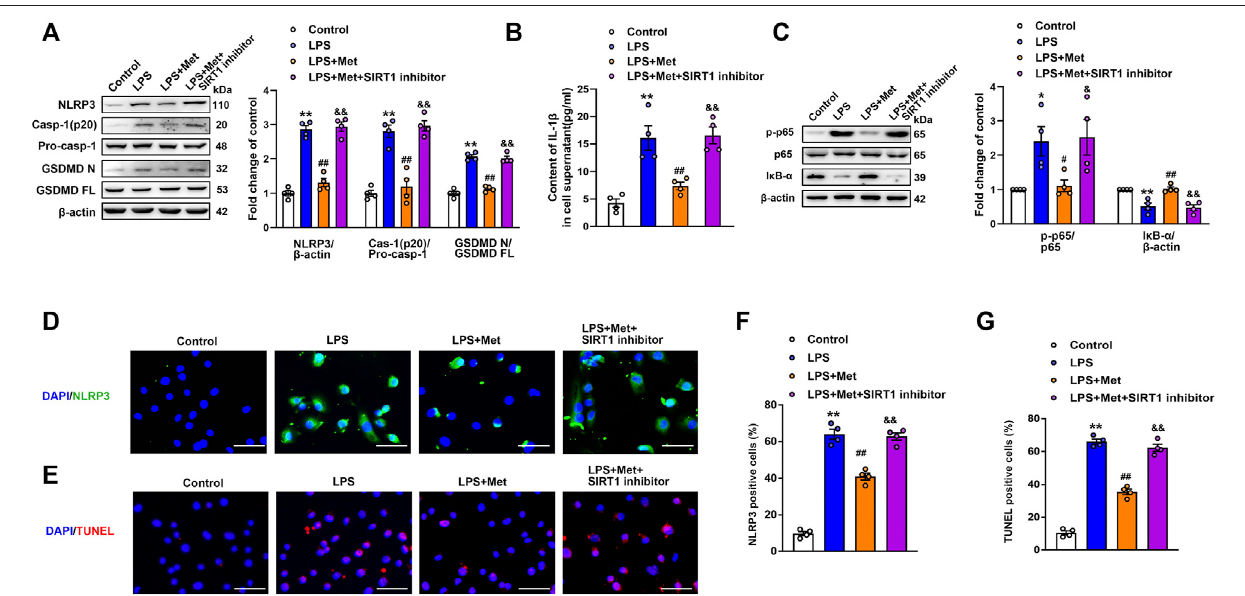
FIGURE5| TheSIRT1inhibitornicotinamidepreventsmetforminfromreducingLPS-inducedpyroptosisinmicepulmonaryECs. (A) Westernblottinganalysiswas used todeterminethelevelsofNLRP3,cleaved caspase1(p20),andN-terminalfragmentofGSDMD.Indicative bandsareshown ontheleftofthehistogram. (B) ELISA was used to determine the protein levels of IL-1 β in supernatants. (C) Representative protein bands of NF- κ B signaling pathway after pretreatment with NAM. (D) ECs were stained with NLRP3 (green). (E) Apoptotic cells were evaluated using TUNEL staining. The nuclei were stained blue using DAPI. (F and G) Percentage of NLRP3- and TUNEL-positive cells. Magni fi cation: ×200. Scale bar, 50 μ m. Data are presented as the mean ± SEM ( n = 4). * p < 0.05, ** p < 0.01 vs. Control group, # p < 0.05, ## p < 0.01 vs. LPS group. & p < 0.05, && p < 0.01 vs. LPS + Met group.